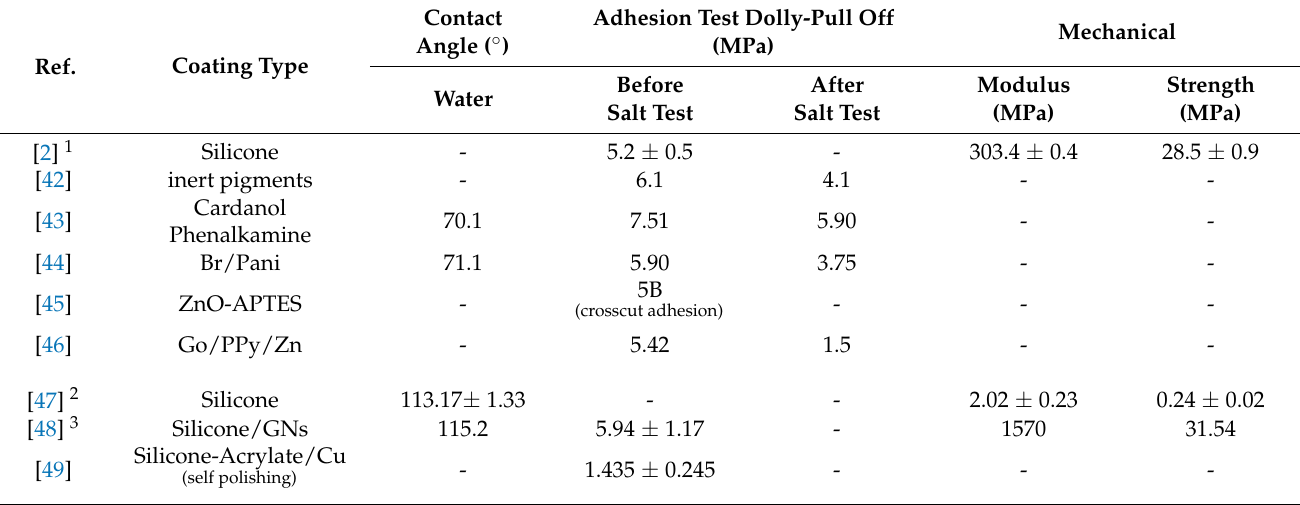
Table 2. Contact angle and mechanical characterization of epoxy-based coatings.